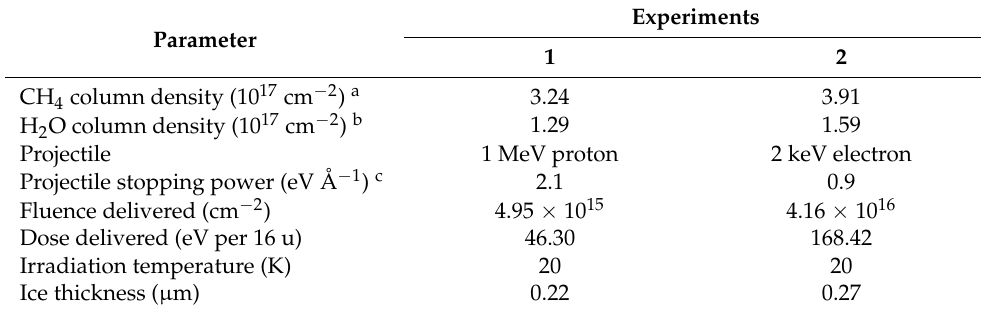
Table 1. Summary of the experiments performed in this study.